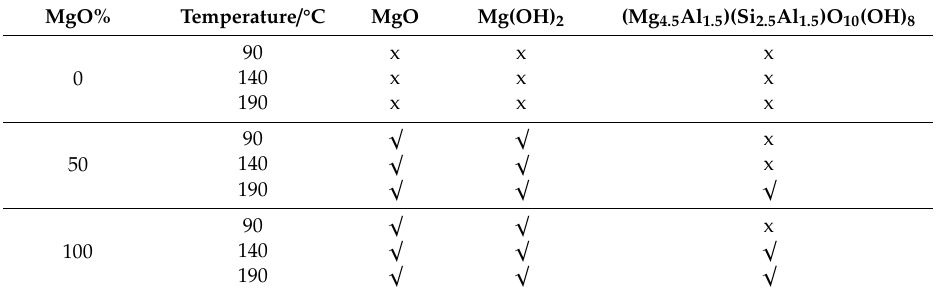
Table 2. XRD patterns of solid products at temperatures < 200 ◦